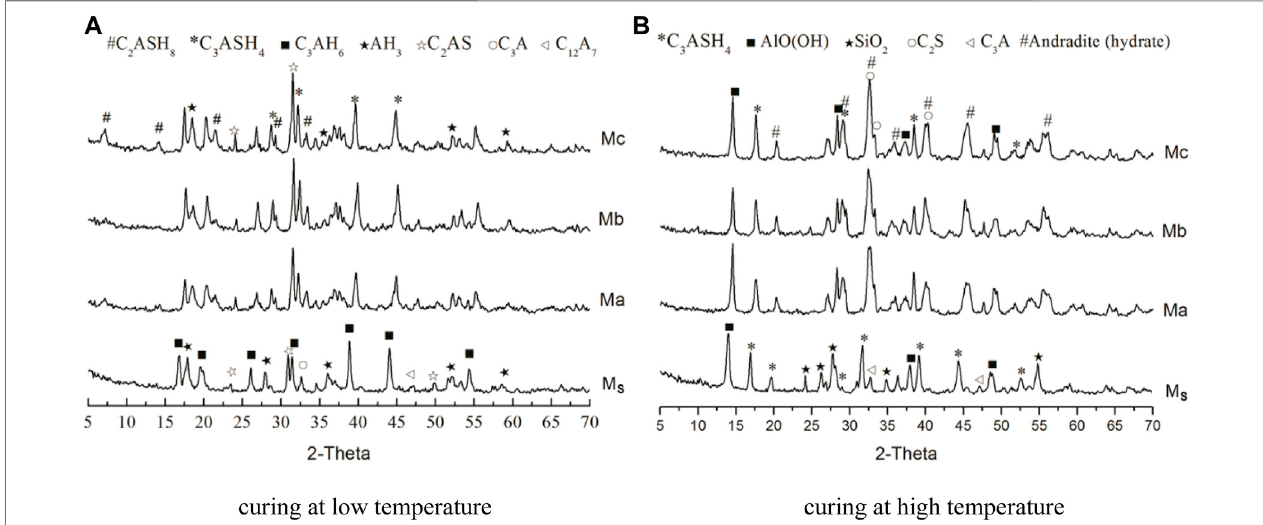
FIGURE 3 | XRD patterns of Ms, Ma, Mb, and Mc. (A) curing at low temperature. (B) curing at high temperature.